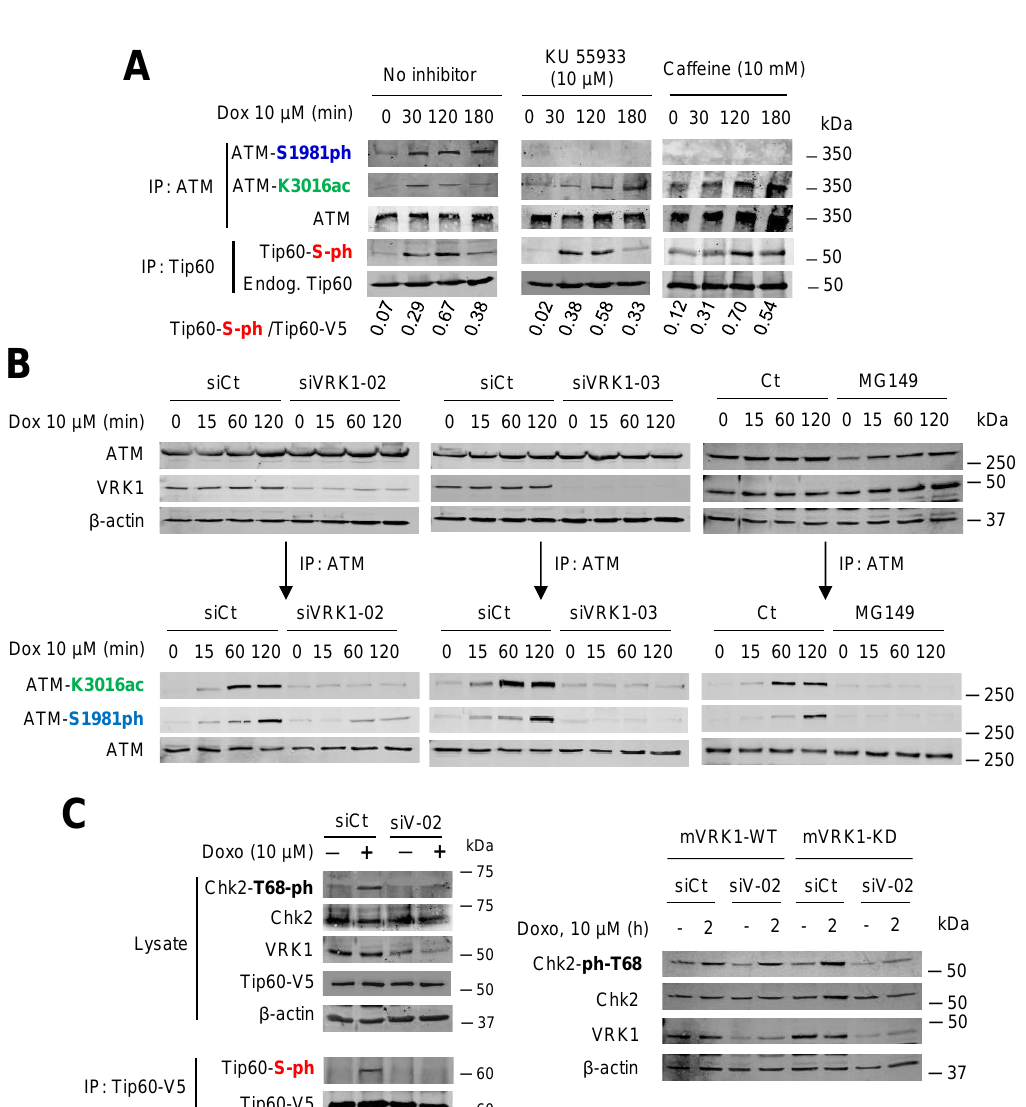
Figure 7. VRK1 is required for the acetylation of ATM by Tip60 in response to DNA damage induced by doxorubicin. ( A ). The phosphorylation and acetylation of ATM, and the phosphorylation of endogenous Tip60 were determined in A549 cells (ATM +/+ ) deprived of serum (0.5% FBS) for 48 h and treated with doxorubicin in combination with KU55933 or ca ff eine that inhibit ATM. The covalent modifications were detected in the immunoprecipitated endogenous proteins with specific antibodies. ( B ). E ff ect of VRK1 depletion with two di ff erent siRNA, and Tip60 inhibition with MG149, on the phosphorylation and acetylation of ATM in response to doxorubicin treatment in A549 cells. Treatment with the MG149 inhibitor was performed by its addition to cultures 12 h before cell lysis. ( C ). E ff ect of VRK1 depletion on the phosphorylation of CHK2 in T68, a downstream phosphorylation target of ATM in response to doxorubicin.